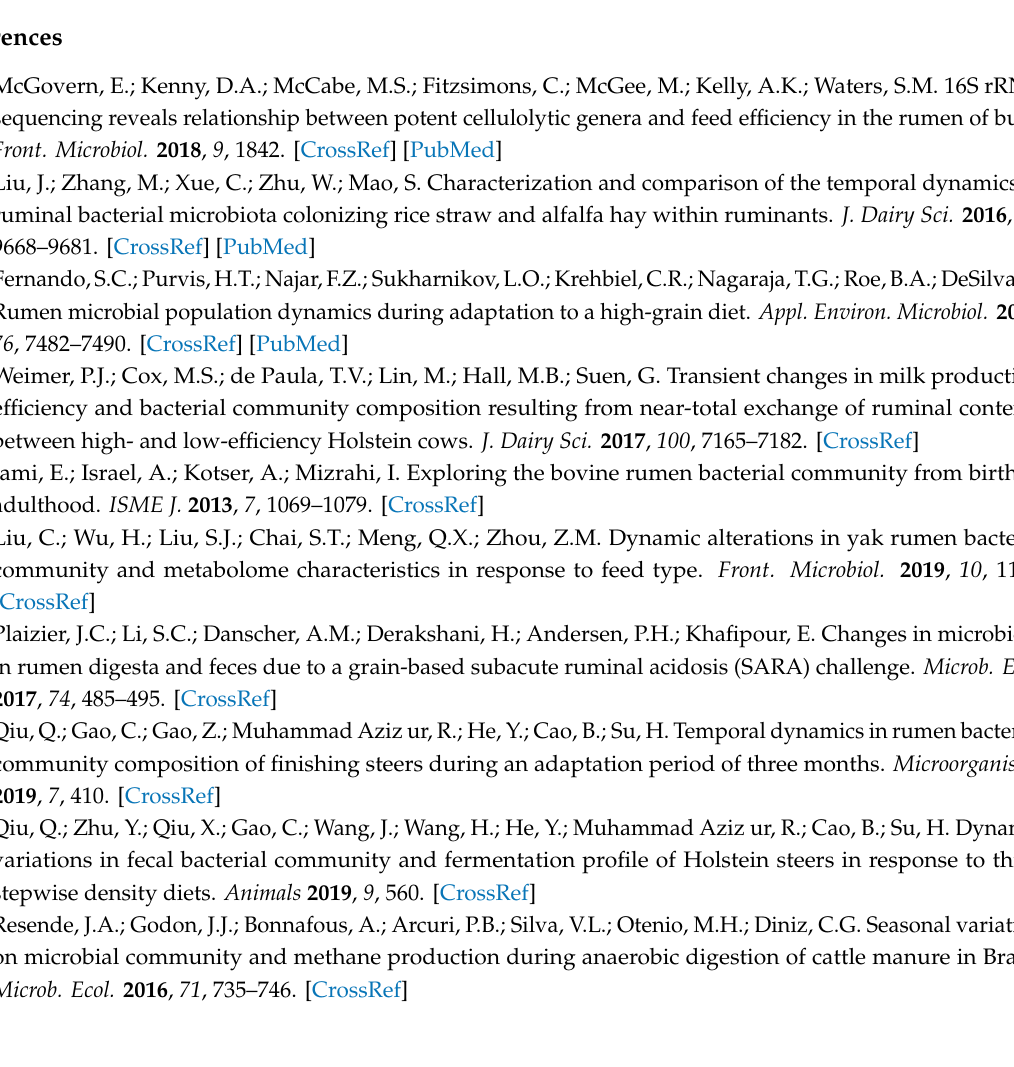
Figure S1: Dynamic changes in ambient temperature ( ◦ C) and relative humidity (%) and temperature-humidity index semimonthly as fattening phases advanced. Figure S2: Shannon-Wiener curves based on Shannon index for high energy and high protein diet (H), moderate energy and moderate protein diet (C), and low energy and low protein diet